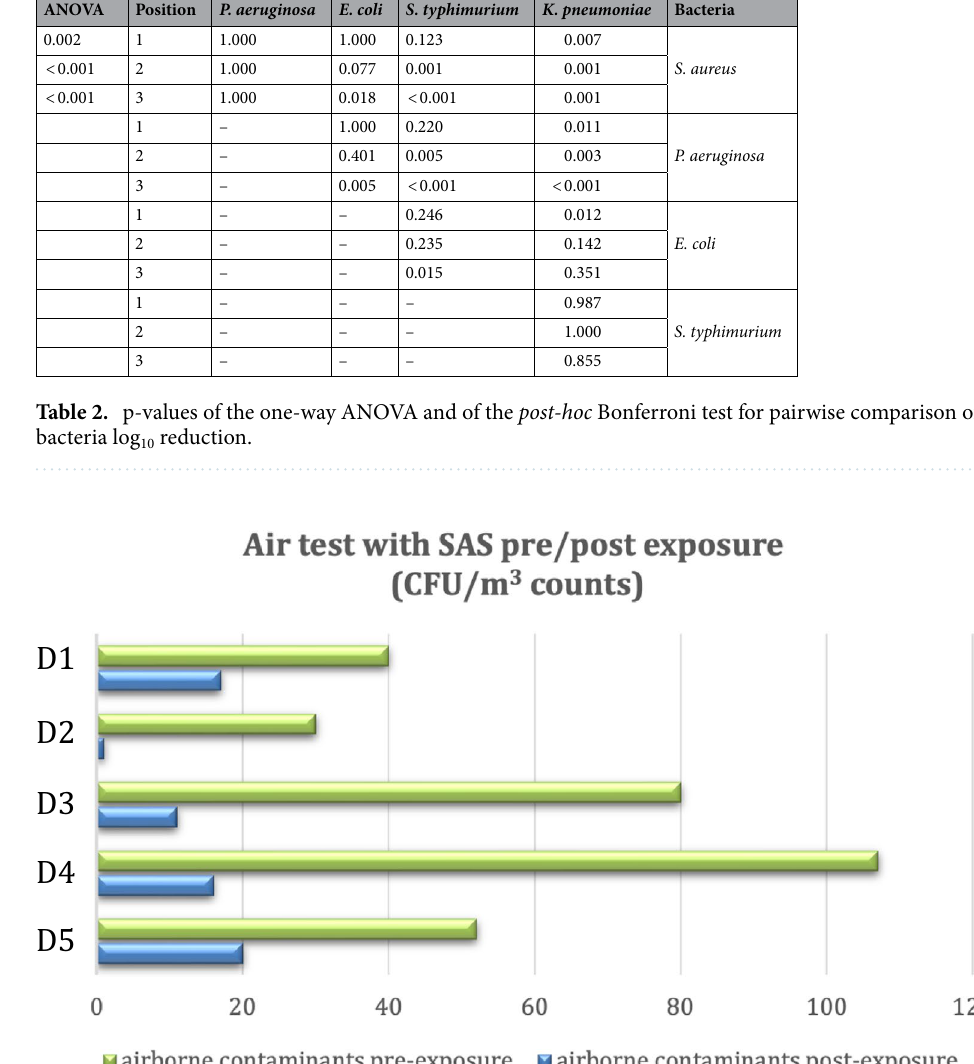
Figure 5. SAS air test. CFU/m 3 counted after several days (D1-5). Airborne contaminants before (green bars) and after (blue bars) the exposure to